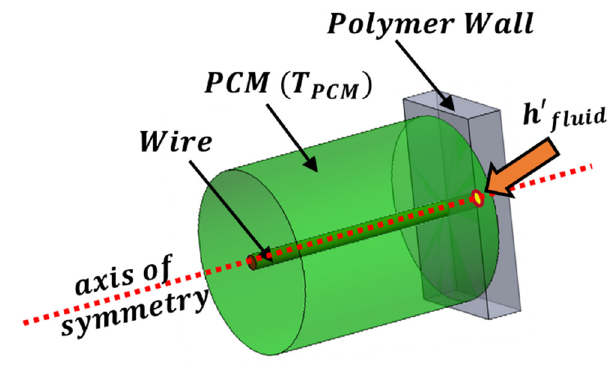
Figure 11. 2D axisymmetric reference model.